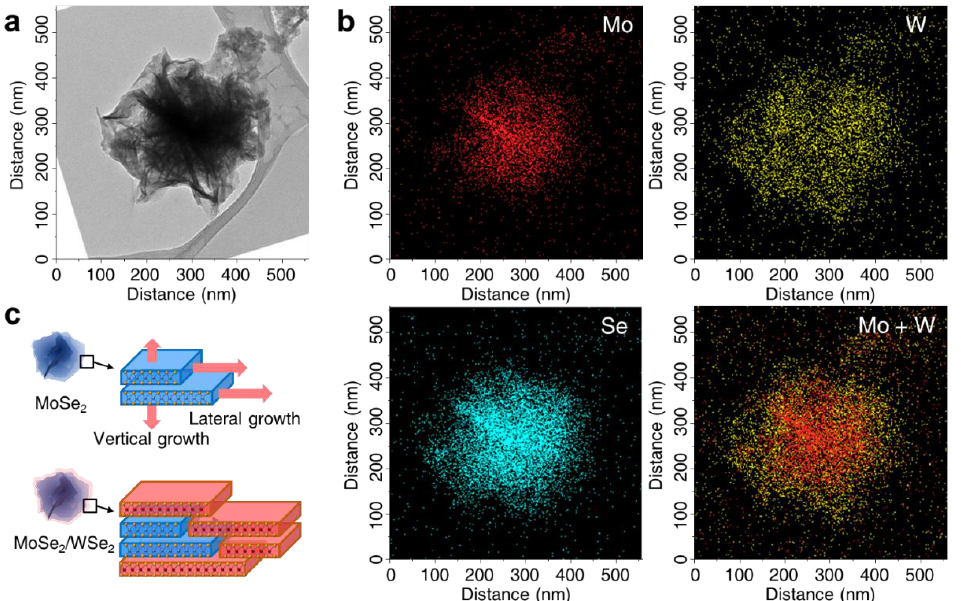
Figure 3. ( a ) Low-magnification TEM image of a MoSe 2 /WSe 2 heterostructure and ( b ) corresponding EDS elemental maps of Mo, W, and Se in the heterostructure. The bottom right panel of ( b ) is a superimposed image of Mo and W spatial distribution. ( c ) Schematic illustration showing the heterostructure formation via vertical and lateral growth of WSe 2 layers on the preexisting MoSe 2 edge surface.